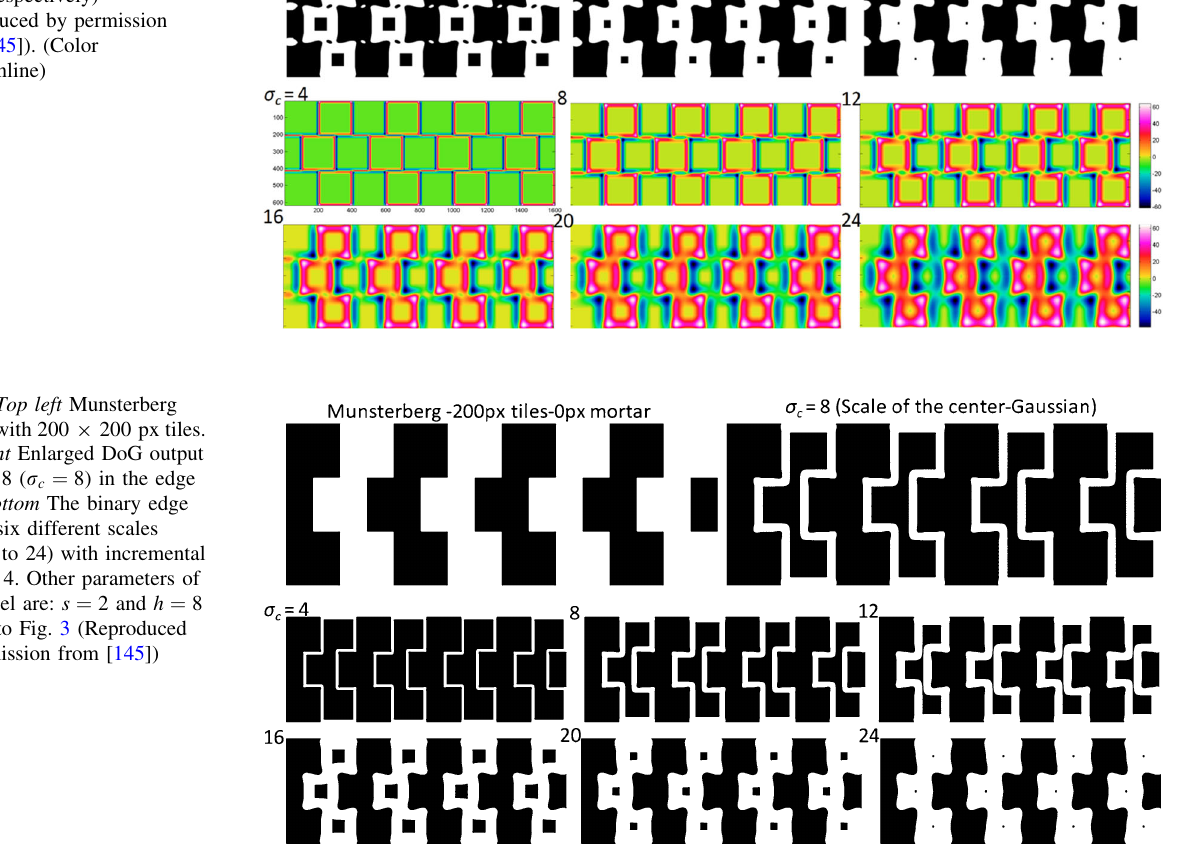
Fig. 3 Top left Cafe´ Wall pattern with 200 9 200 px tiles and 8 px mortar. Top right Enlarged DoG output at scale 8 ( r c ¼ 8) in the edge map. Centre The binary edge map at six different scales ( r c ¼ 4 to 24 with incremental steps of 4). Bottom Jet white colour map of the above edge map. Rather than the centre Gaussian, other parameters of the model are: s ¼ 2, and h ¼ 8 (the Surround and Window ratios, respectively) (Reproduced by permission from [145]). (Color